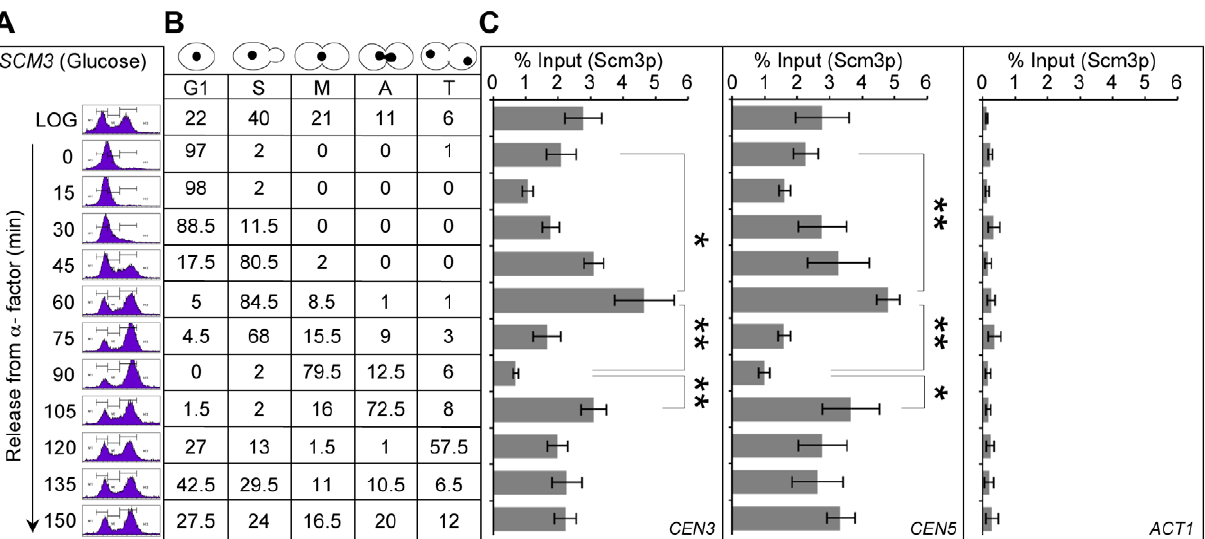
Figure 3A, 3B) between the control ( SCM3 ) and GALSCM3 strains. We confirmed the latter observations in an additional cell cycle with nocodazole and released into alpha factor (Figure S6). We did